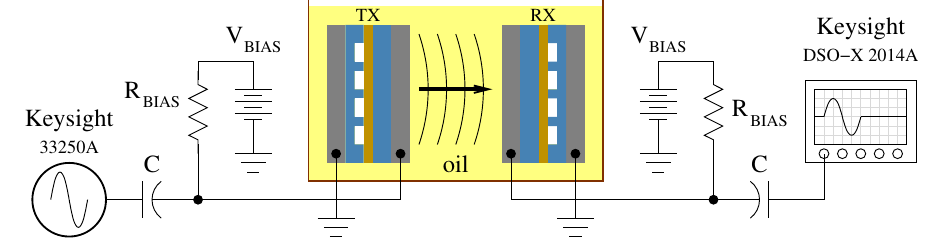
Figure 5. Setup for pitch–catch experiment.